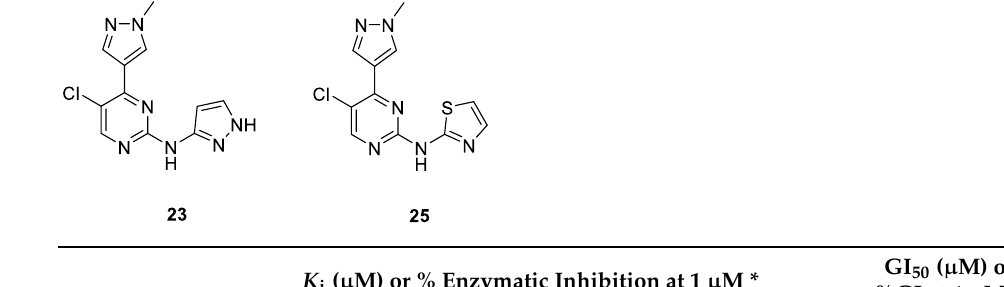
Table 3. Inhibition of CDK kinase activity and A2780 cell viability by 23 and 25.